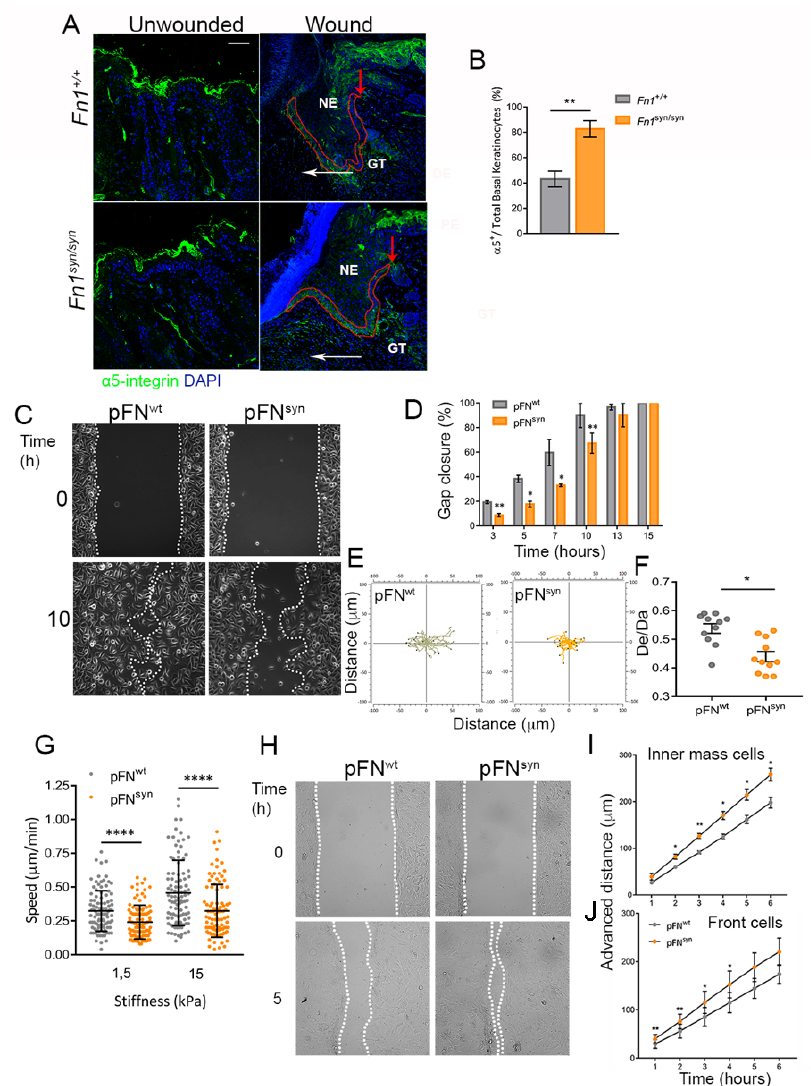
Figure 2. Re-epithelialization and characterization of keratinocyte migration on FN syn . ( A ) Representative immunofluorescence for α 5- integrin (green) in unwounded skin and Fn1 +/+ and Fn1 syn/syn wounds at 4 daw and nuclei marked with DAPI (blue). Red arrows mark the start of the α 5- integrin- expressing basal keratinocyte layer in the wounds; white arrows indicate the sense of keratinocyte tongue migration. ( B ) Percentage of α 5 integrin-positive basal migratory keratinocytes referred to the total number of basal keratinocytes in the epidermal tongue (defined by a line of red dots) ( n = 8, 6). ( C ) Images of in-vitro keratinocyte single-cell migration on pFN wt and pFN syn at 0 and 10 h after self-insert removal. ( D ) Percentage of gap closure calculated as the free-cell area at each time point relative to the initial area for keratinocytes migrating on pFNwt or pFNsyn at shown time points. ( E ) Representative cell tracks on pFN wt and pFN syn . ( F ) Quantification of cell directionality in three different biological replicates, as distance Euclidean/distance accumulated (De/Da). ( G ) Analysis of cell speed of keratinocytes seeded at low density on PDMS gels with rigidities of 1.5 and 15 kPa. Three different biological replicates were analysed and around 30–50 cells were tracked in each experiment. ( H ) Representative images of keratinocyte collective migration at 0 and 5 h on pFN wt and pFN syn . ( I ) Analysis of the cells advance in the inner mass over time. ( J ) Analysis of front cells advance over time. Four different areas were recorded per experiment and each dot represents around 8–10 cells per area for each different replicate. Results are the mean ± SEM from three independent